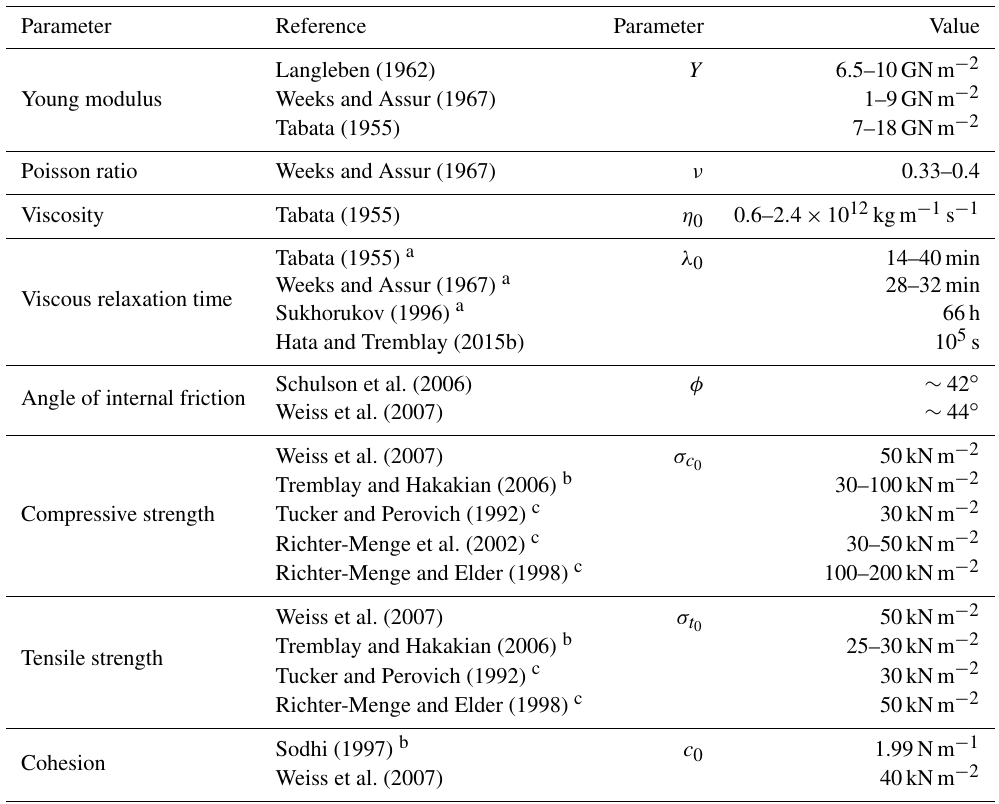
Table 1. Material strength parameters from